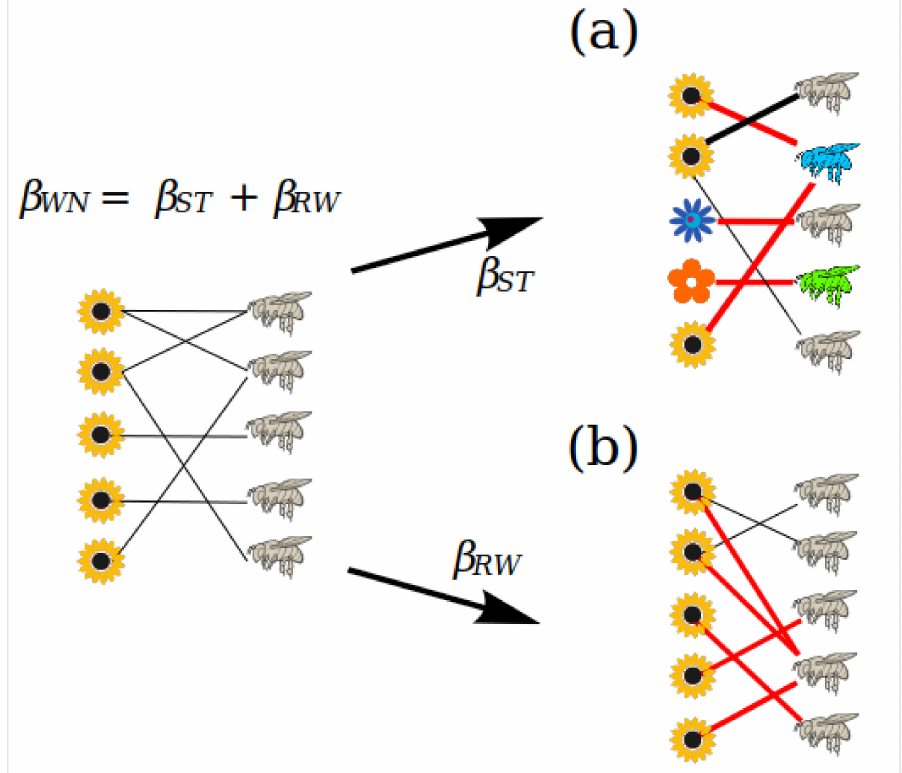
Figure 3. Conceptual diagram showing the two components of the turnover of interactions ( β WN ). ( a ) Turnover of interactions generated by the turnover of species ( β ST ). Note that despite the turnover of species the index measures how the interaction changes between networks (red and thick lines). ( b ) Turnover of interaction generated by the rewiring of interactions, the same species interacting in di ff erent ways between two